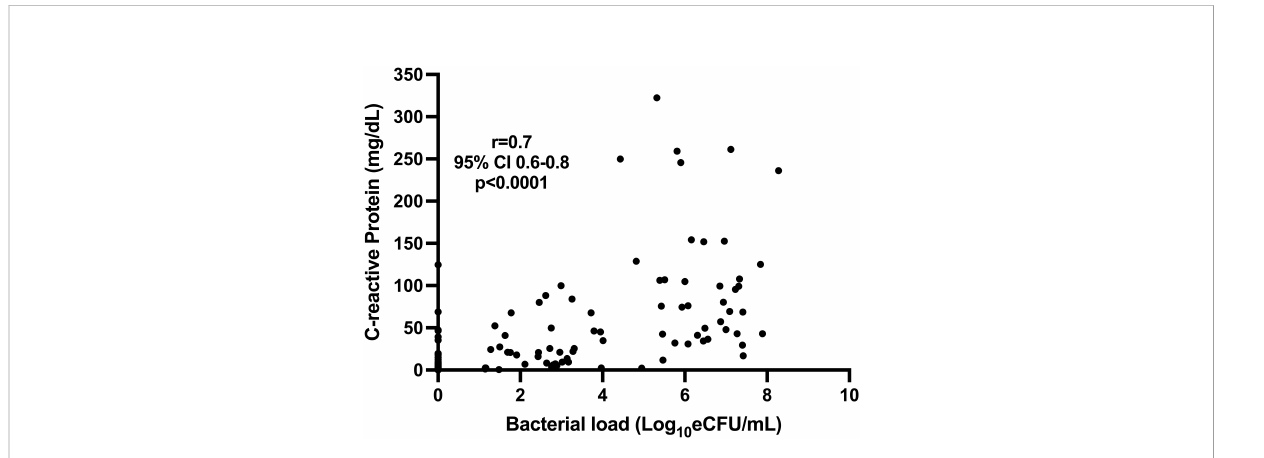
FIGURE 3 Correlation of blood CRP and sputum TB bacillary load measured by TB-MBLA in 43 patients at baseline, month 2, and month 6.